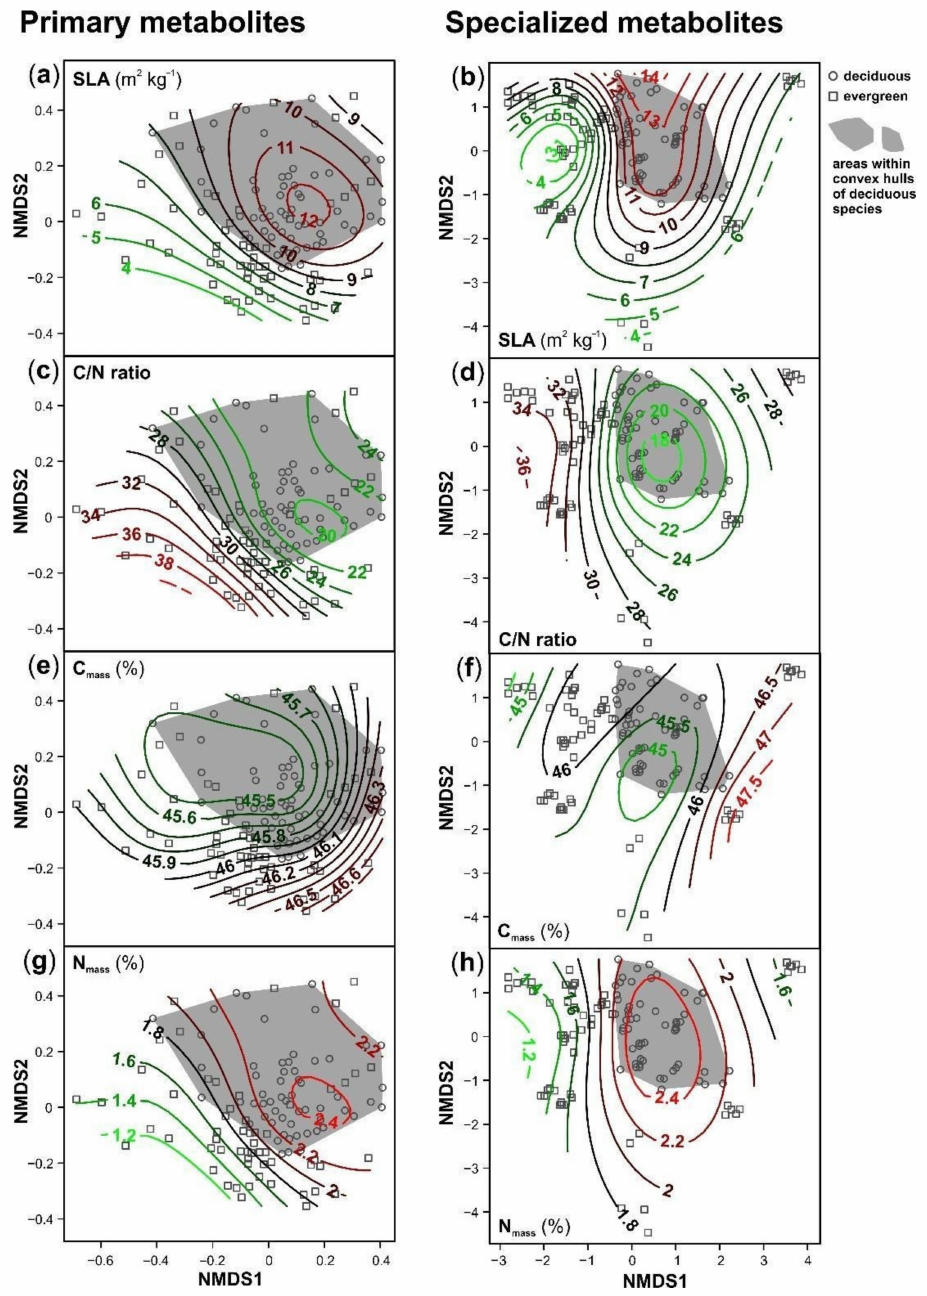
Figure 5. Simplified non-metric multidimensional scaling plots (for detailed plots see Figure 4) of relative concentrations of metabolic features of the primary ( left ) and specialized ( right ) metabolism detected in leaves of 20 plant species (deciduous: circles; evergreen: squares). The deciduous species are highlighted by gray areas that are framed by convex hulls (closed curves surrounding all data points with minimum perimeter) for this group. Contour lines (green: low values; red: high) representing surface fits of generalized additive models for: ( a , b ) specific leaf area (SLA); ( c , d ) carbon (C) to nitrogen (N) ratio; ( e , f ) C content (C mass ); ( g , h ) N content (N mass